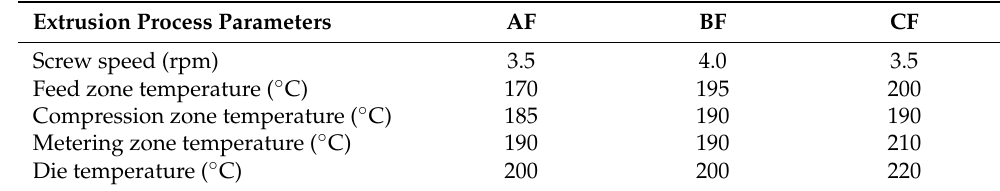
Table 1. Extrusion process parameters for filaments: filament 100% wt. PLA Ingeo 4043D